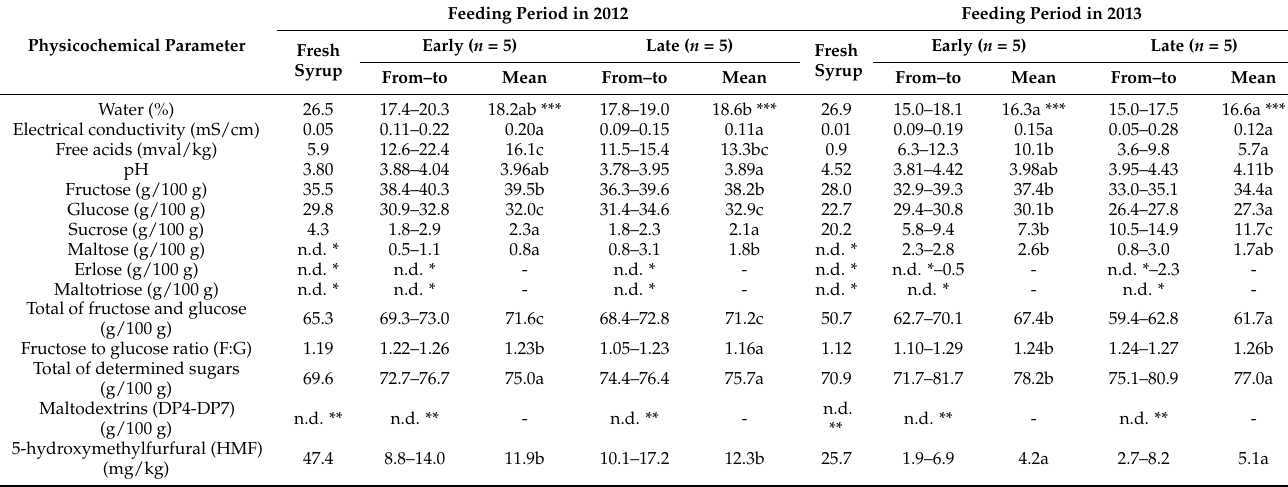
Table 5. Physicochemical composition of winter stores produced by bees fed with inverted saccharose syrup (Apiinvert). Feeding Period in 2012 Feeding Period in Physicochemical Parameter